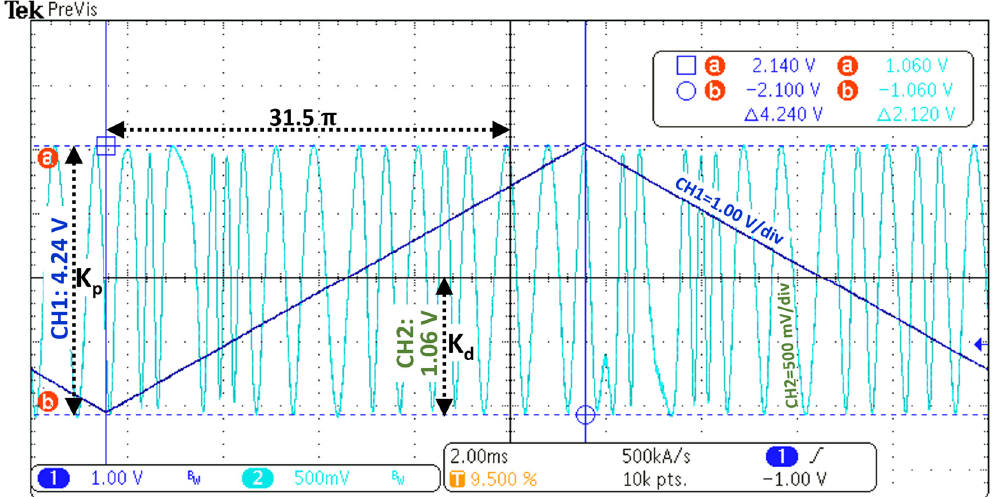
Figure 5. Coefficients K (cid:2926) (PZT with optical coil) and K (cid:2914) (photodiodes) experimentally obtained.